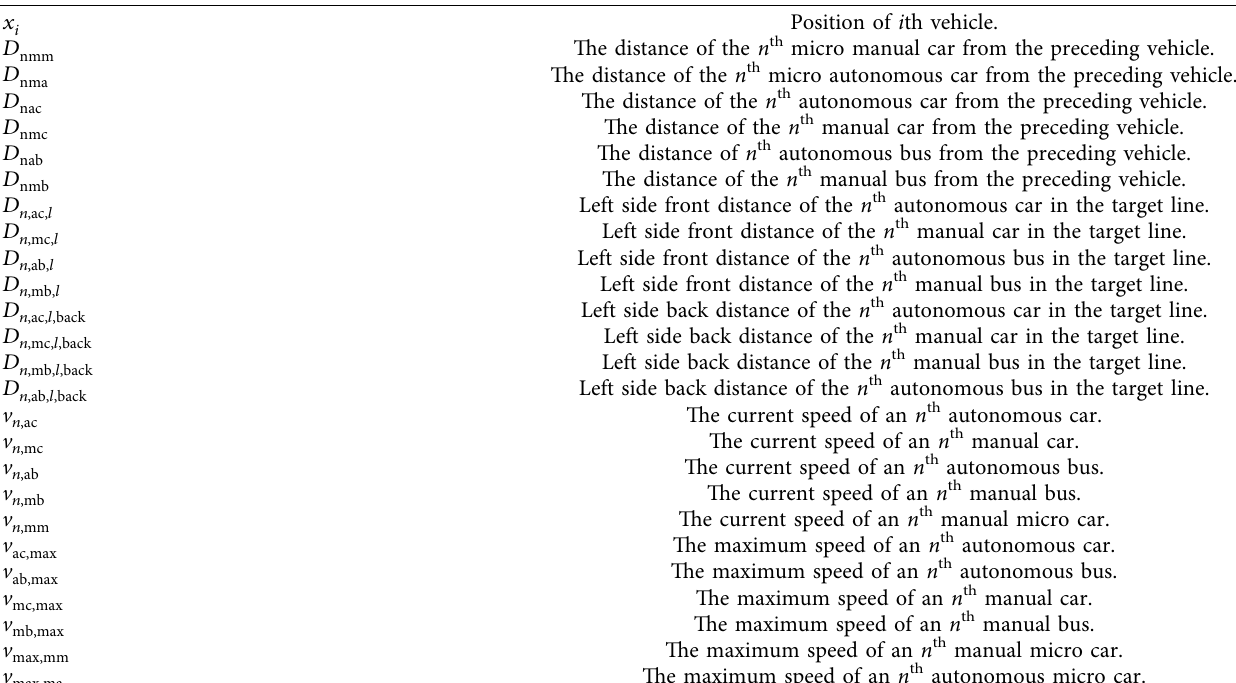
Table 1: Symbols and